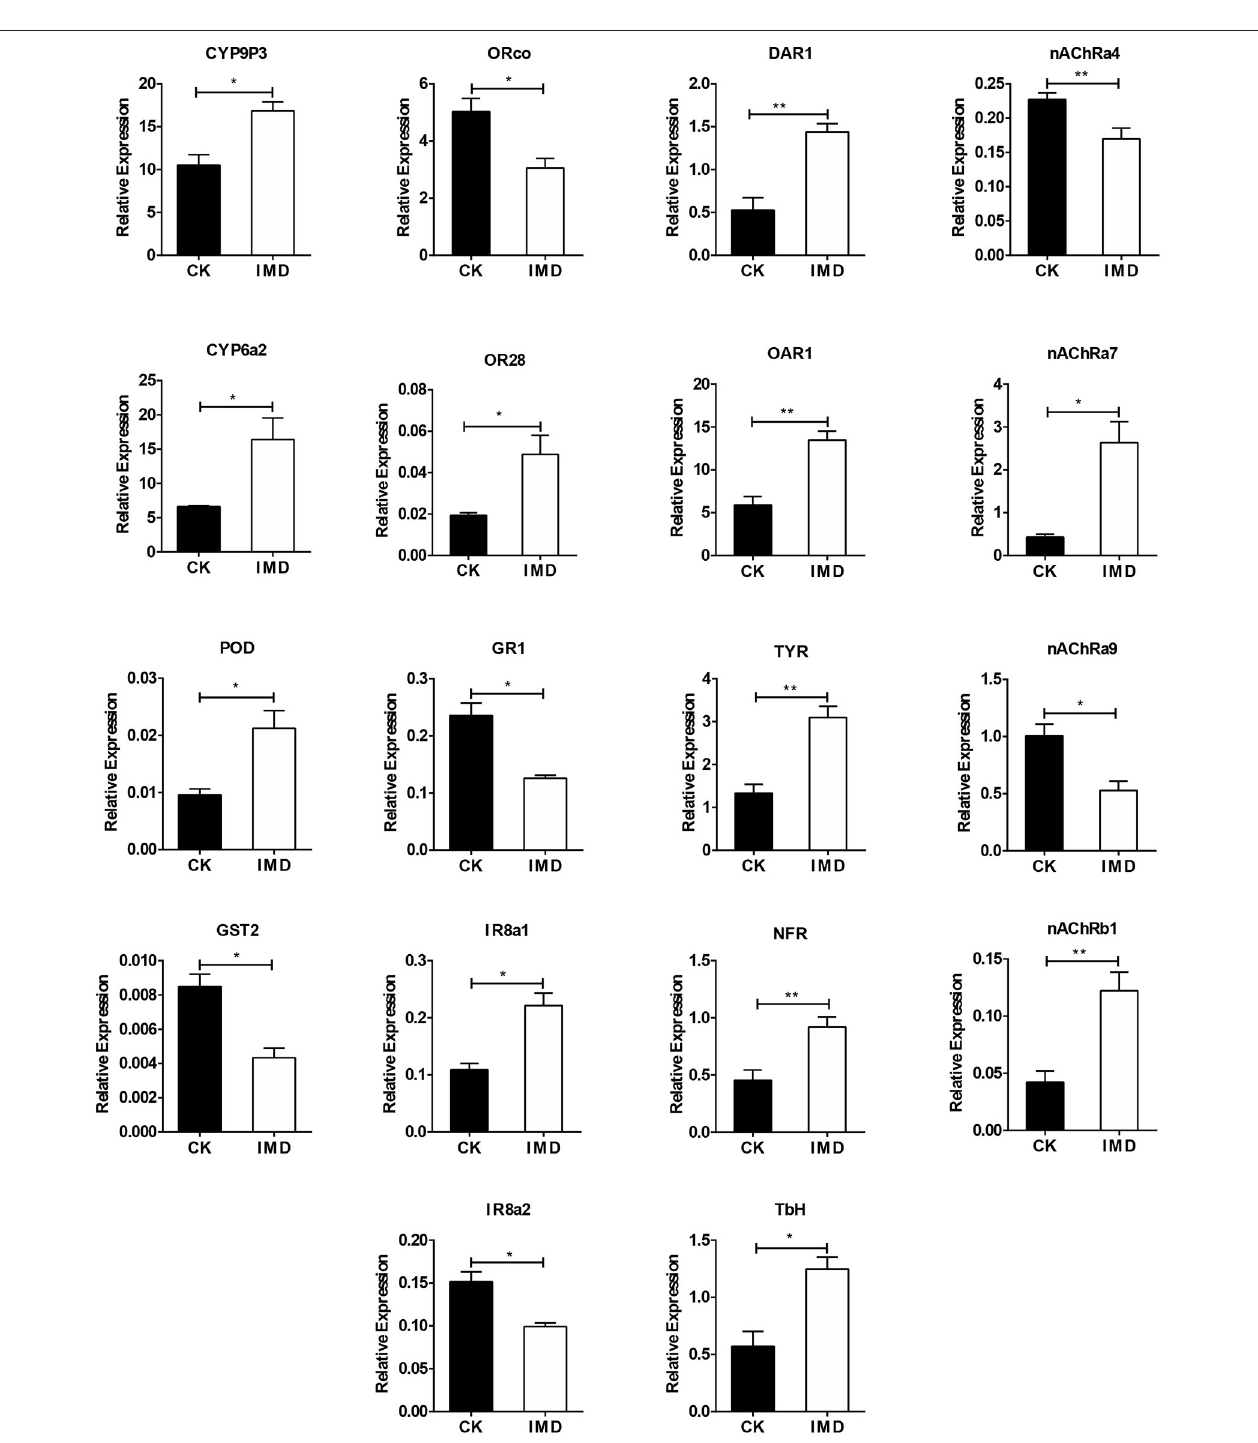
FIGURE 7 | Validation of expression of selected genes using qPCR. DAR1, dopamine receptor 1; SNF, short neuropeptide F; NFR, neuropeptide FF receptor 2; TYR, putative tyramine receptor 2; TbH, tyramine beta-hydroxylase. Asterisk over the bars designate a significant difference based on student’s t -test: * P < 0.05, ** P < 0.01, *** P < 0.001, and the error bars is ± SE bars. N = 3.